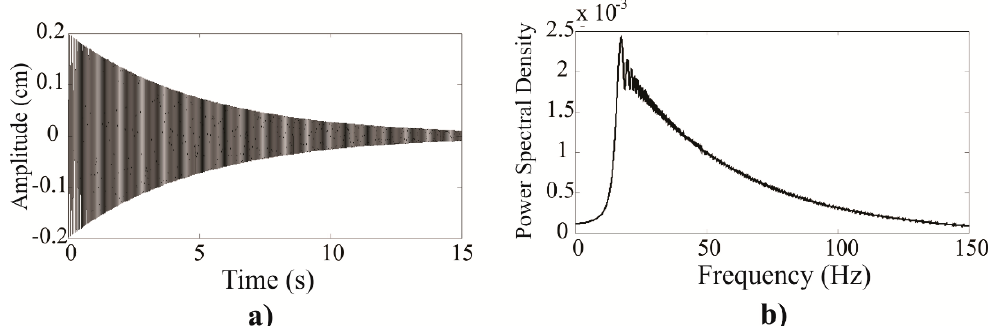
Figure 5. ( a ) Sinusoidal sweep excitation and ( b ) synthesized signal spectrum.